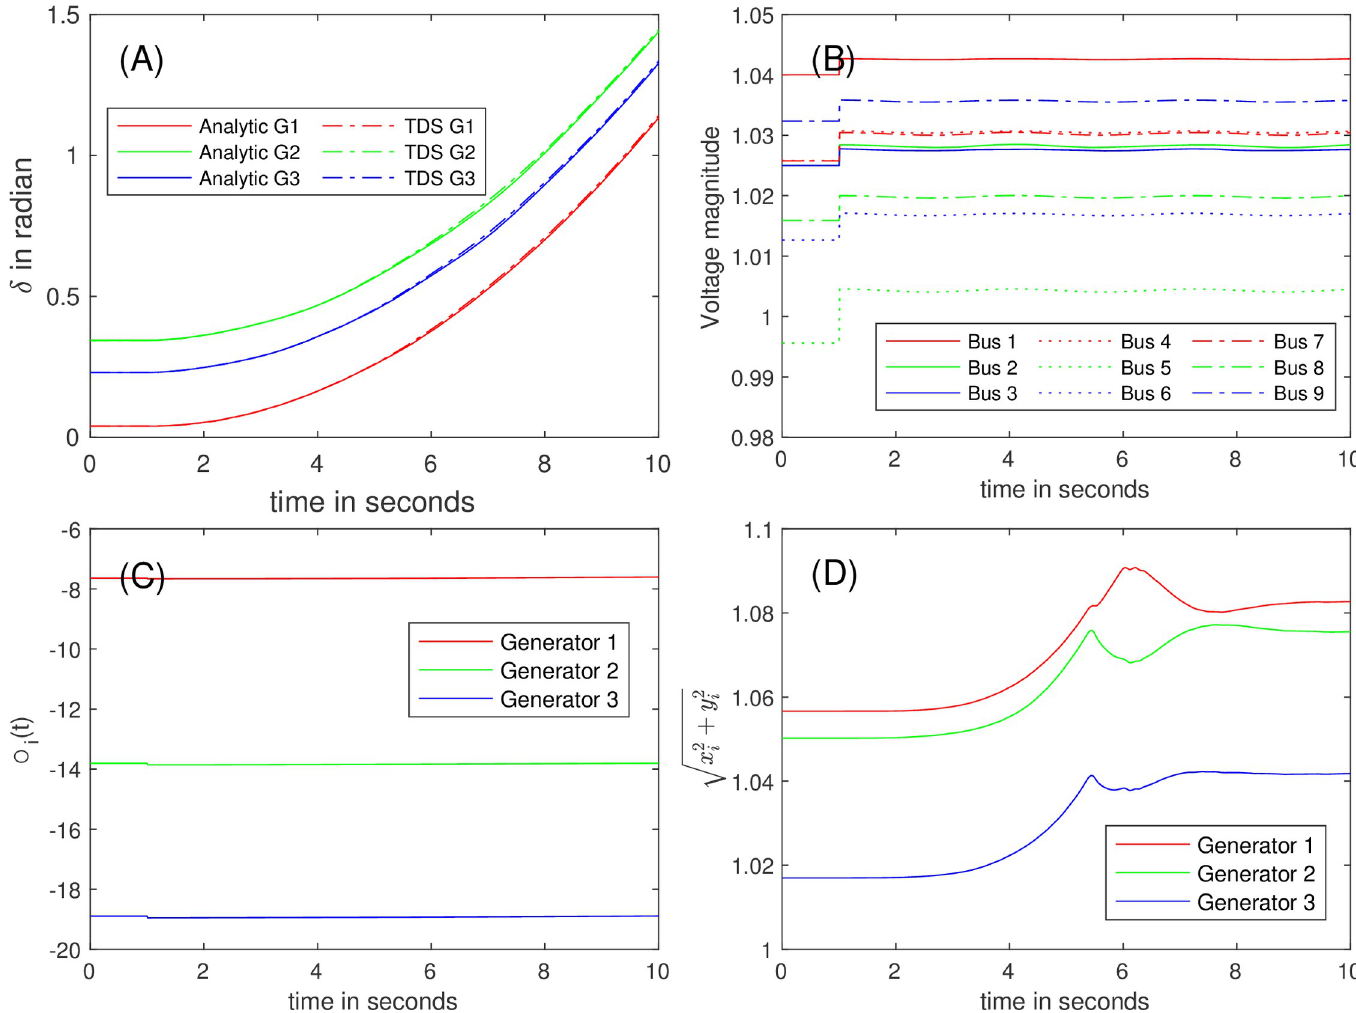
Fig 6. The trajectories of (A) δ , of (B) E , of (C) O i ( t ), and of (D) the magnitudes of the internal voltages after 10% of loss of the load at Bus 8 (red arrow in Fig 5).